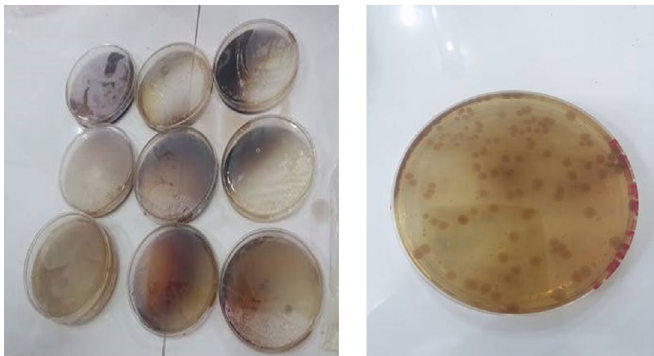
Fig. 1. Plates poured with isteria selective agar